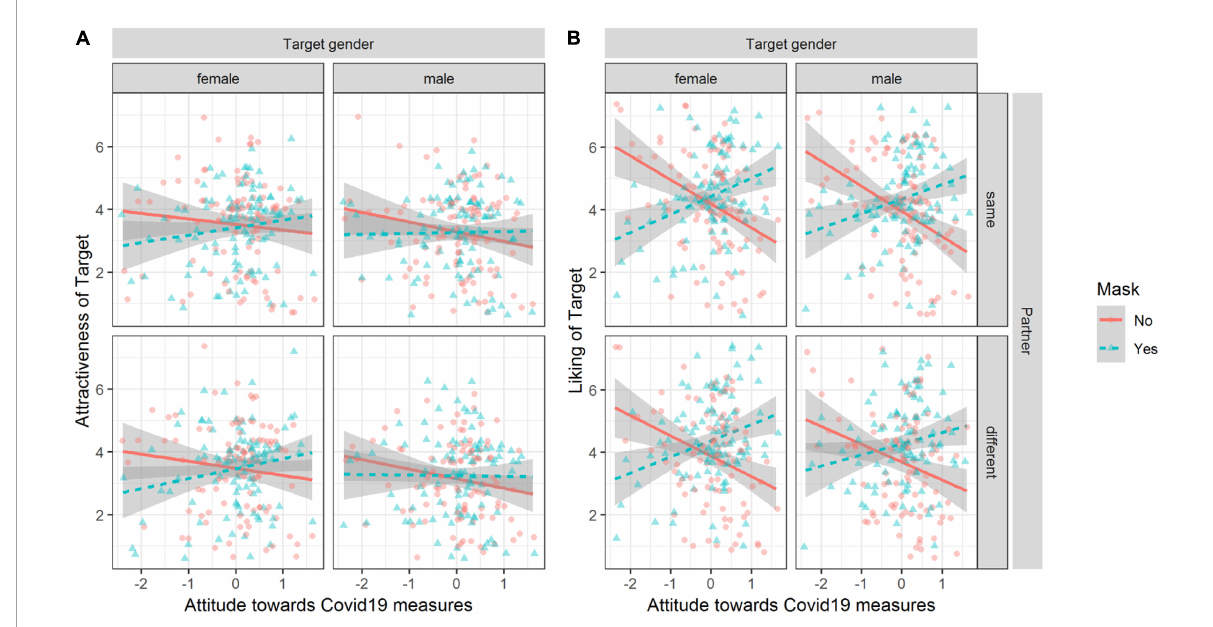
FIGURE3 Observed attractiveness and liking ratings dependent on attitude, mask, target person gender, and partner. Plot (A) for attractiveness. Plot (B) for liking. Lines depict linear regression of Y on X and the shaded area shows the 95% CI of the estimate. Data points are jittered to avoid